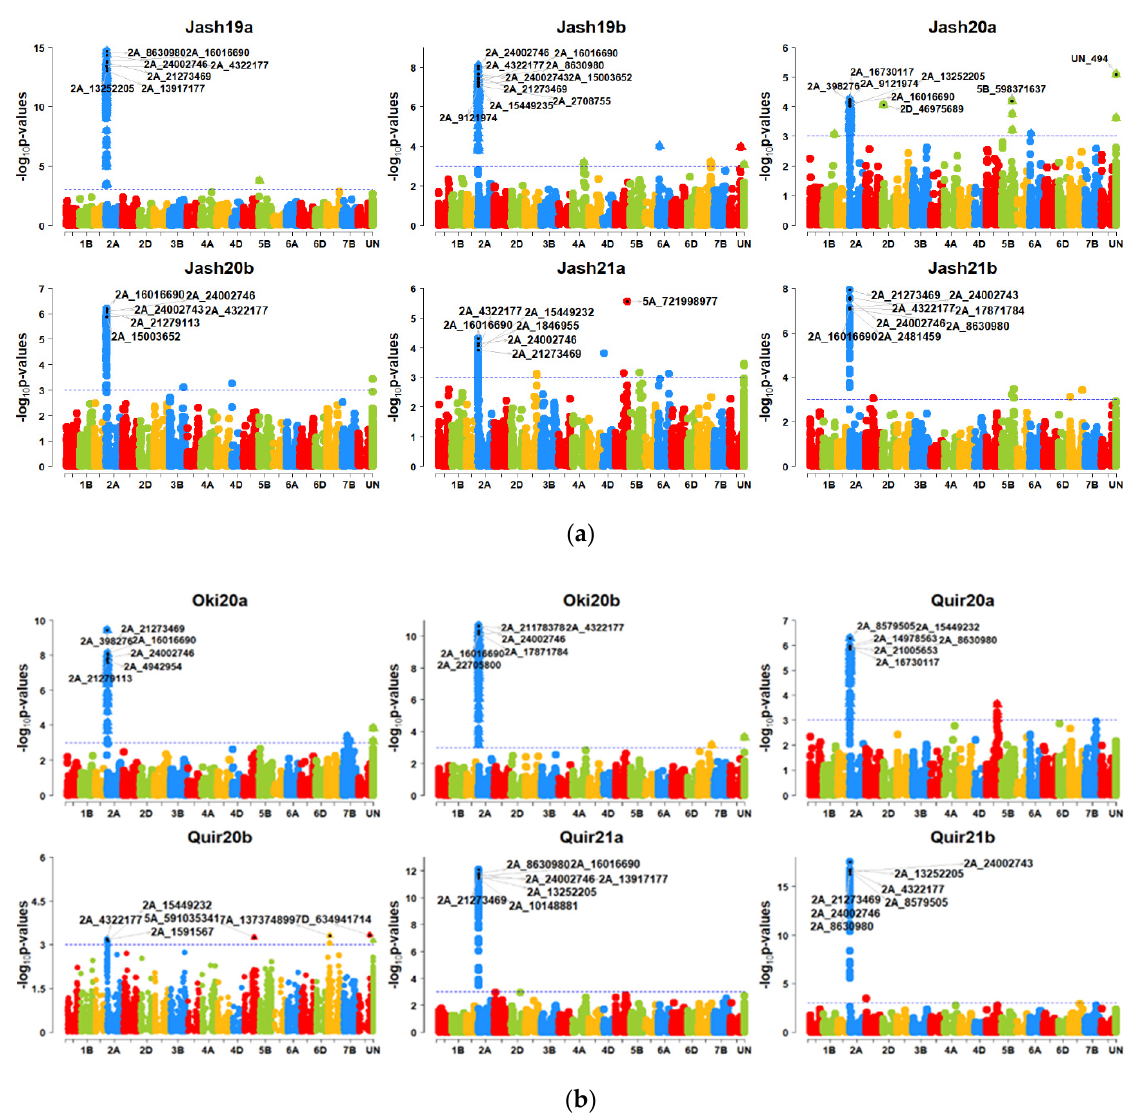
Figure 4. ( a ) Manhattan plots for wheat blast indicating the marker-blast associations obtained using genome-wide association mapping for six experiments in Jashore. Jash (Jashore), 19 (2018–2019 cycle), for wheat blast indicating the marker-blast associations obtained using genome-wide association mapping for two experiments in Okinawa and four experiments in Quirusillas. Quir